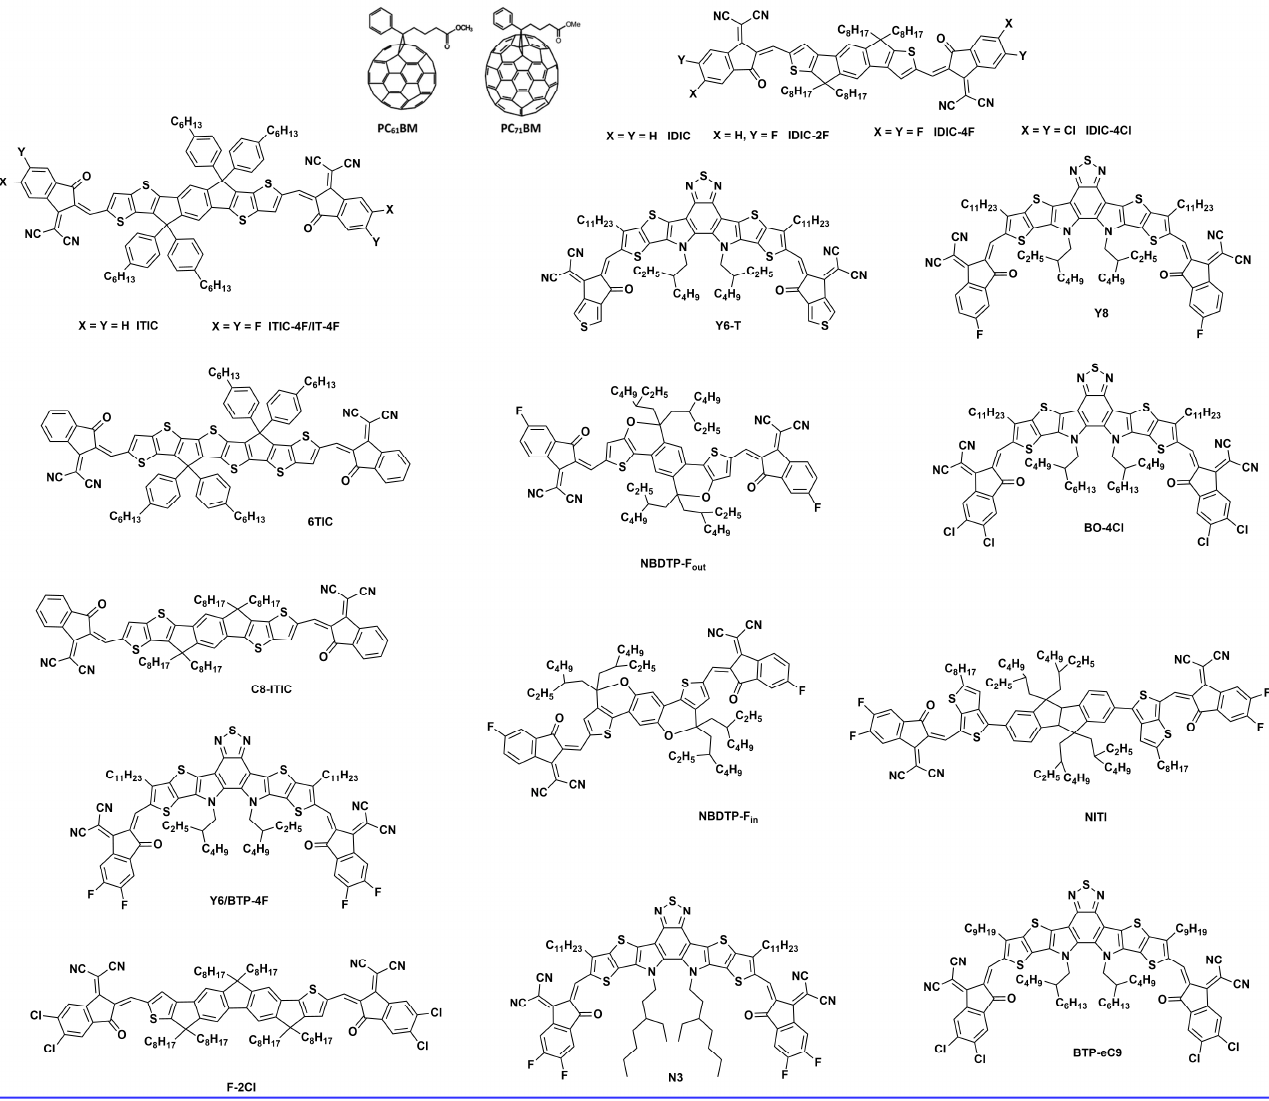
Figure 7. Chemical structures of the small molecular acceptor address in this review.